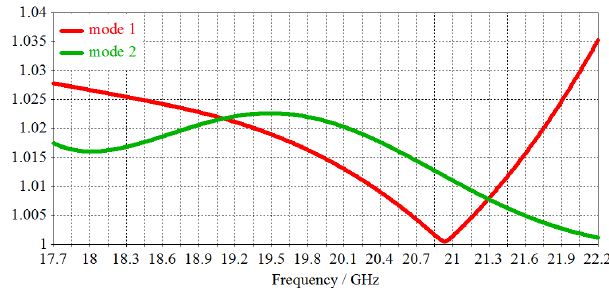
FIGURE 9. VSWR of the optimized waveguide iris polarizer for